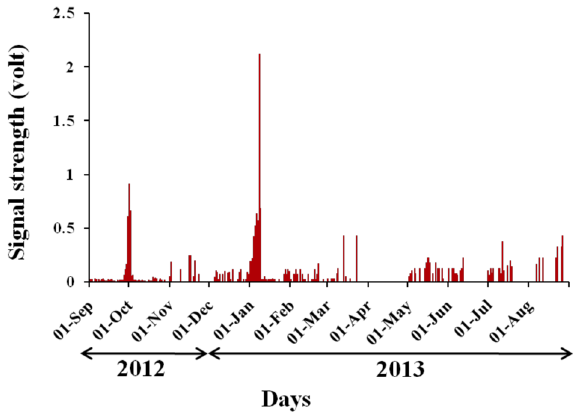
Figure 2. Signal strength (volts) received at GU, from the Chukha FM transmitter for the period September 2012 to September 2013. The two events marked by arrow heads show sudden appearance of relatively strong